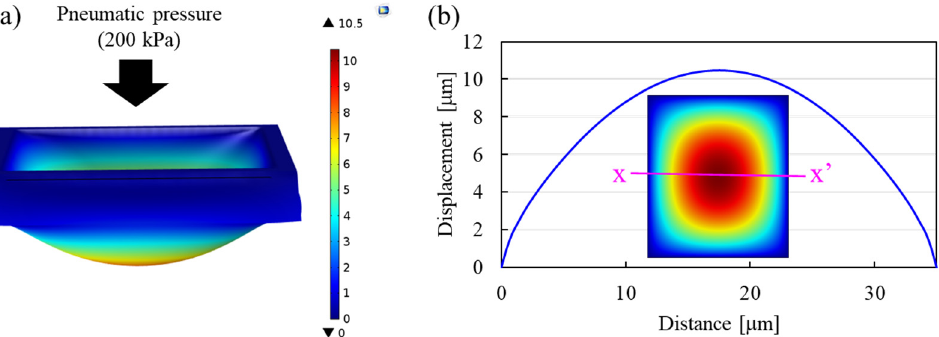
Figure 2. 3D FEA for vertical-directional displacement of pneumatic valve. ( a ) Simulation results under the applied pressure of 200 kPa. ( b ) Displacement profile along cross-sectional line (xx’) in the inset that represents the nodal displacement of the bottom surface of the valve. The scale bar in ( a ) represents vertical-directional nodal displacement in both ( a , b ).